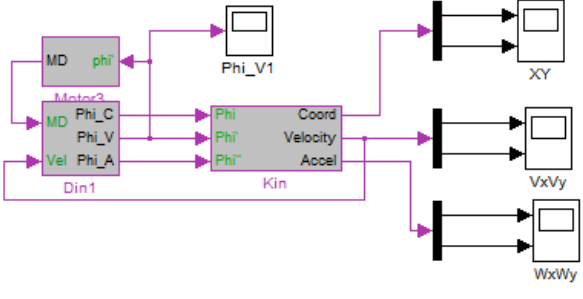
Figure 5. General view of the Simulink model of vibrating